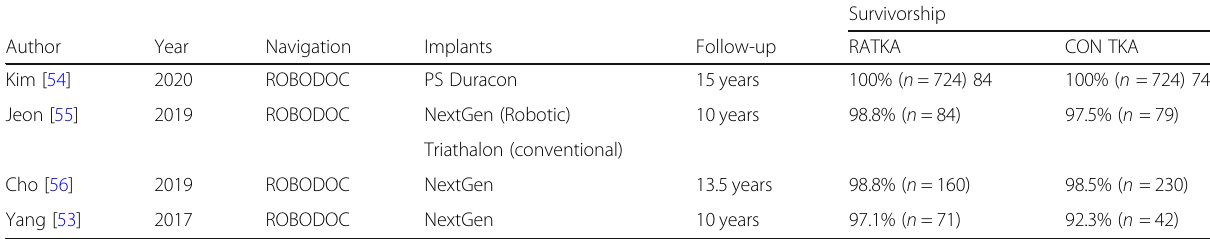
Table 5 Robotic TKA versus Conventional TKA